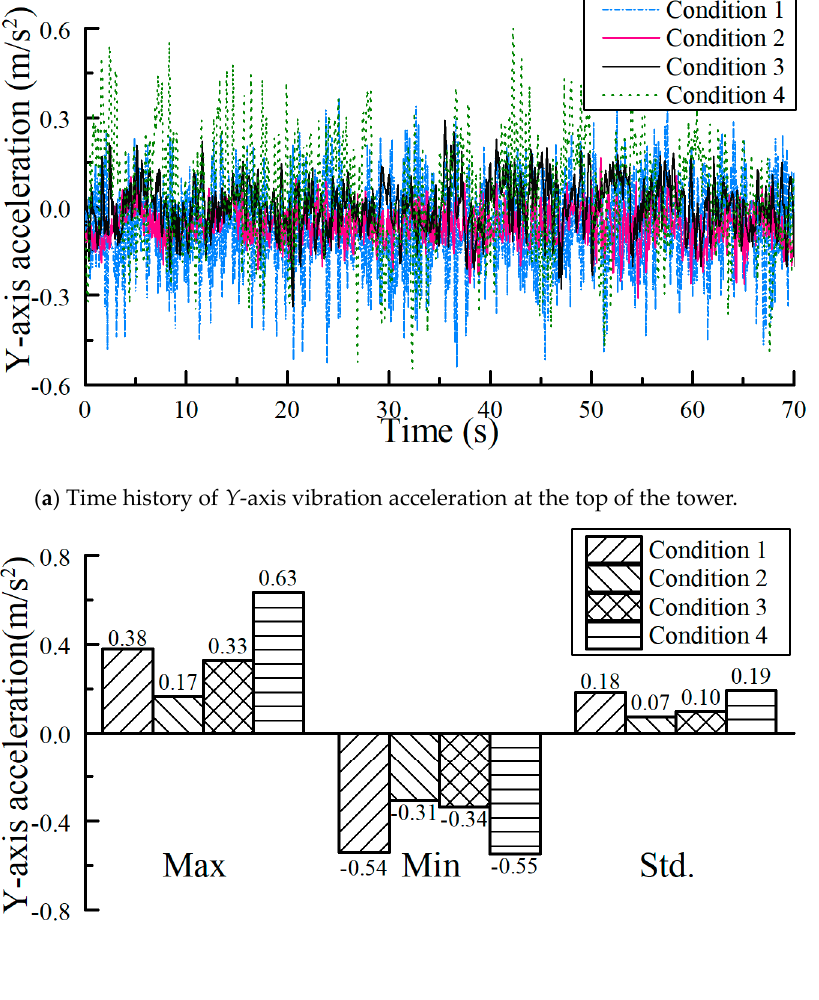
Figure 14. Y -axis vibration acceleration at the top of the tower.